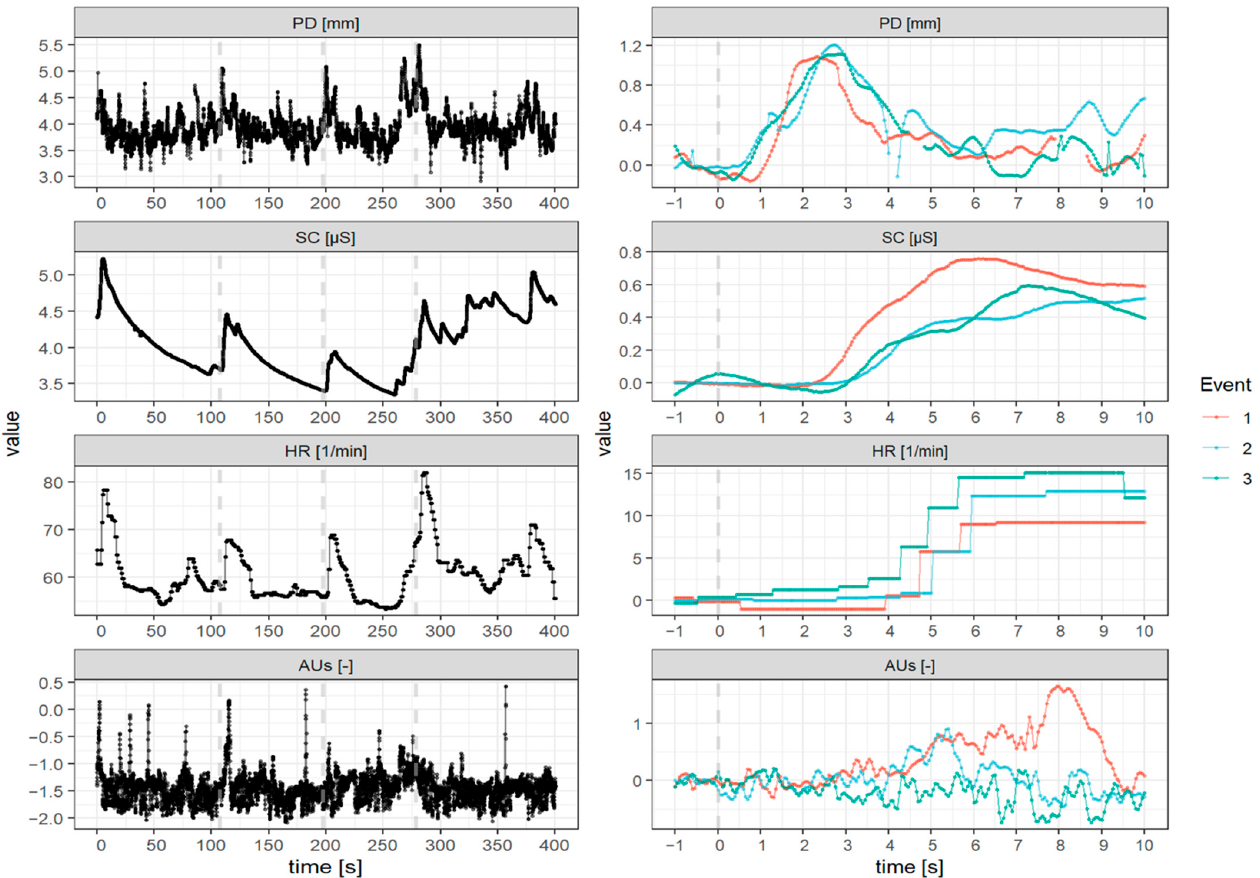
Figure 2. Pupil diameter (PD), skin conductance (SC), heart rate (HR) and action units (AUs) of one participant in the simulator drive with three threatening traffic events (onset of events in dashed lines). Left: raw data for the entire drive; right: event-logged data after baseline subtraction.